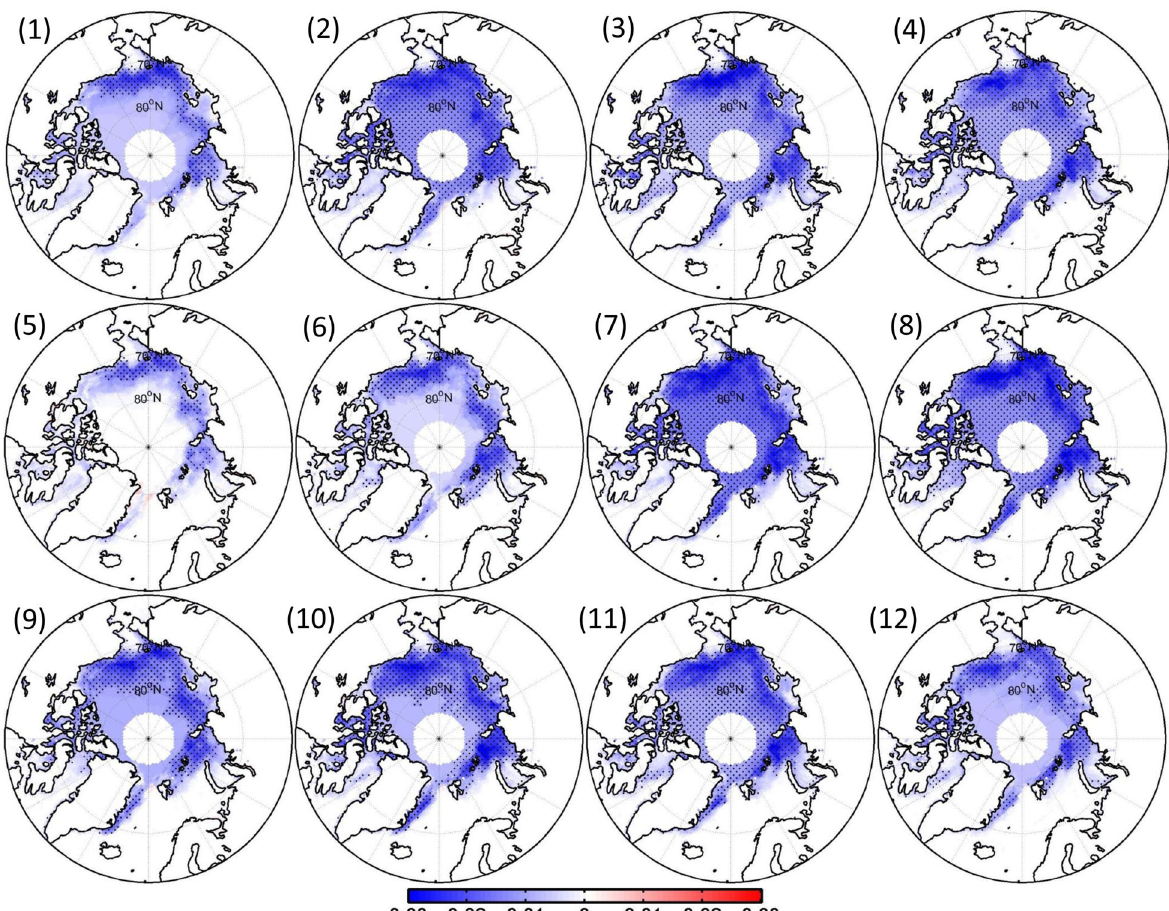
Fig. 5 Trends in the percentage of August – October Arctic sea ice presence per each SOM node occurrence (units: yr − 1